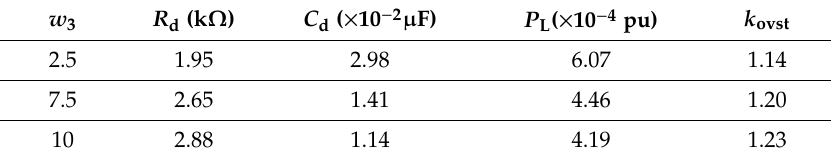
Table 8. E ff ects of w 3 on Optimization